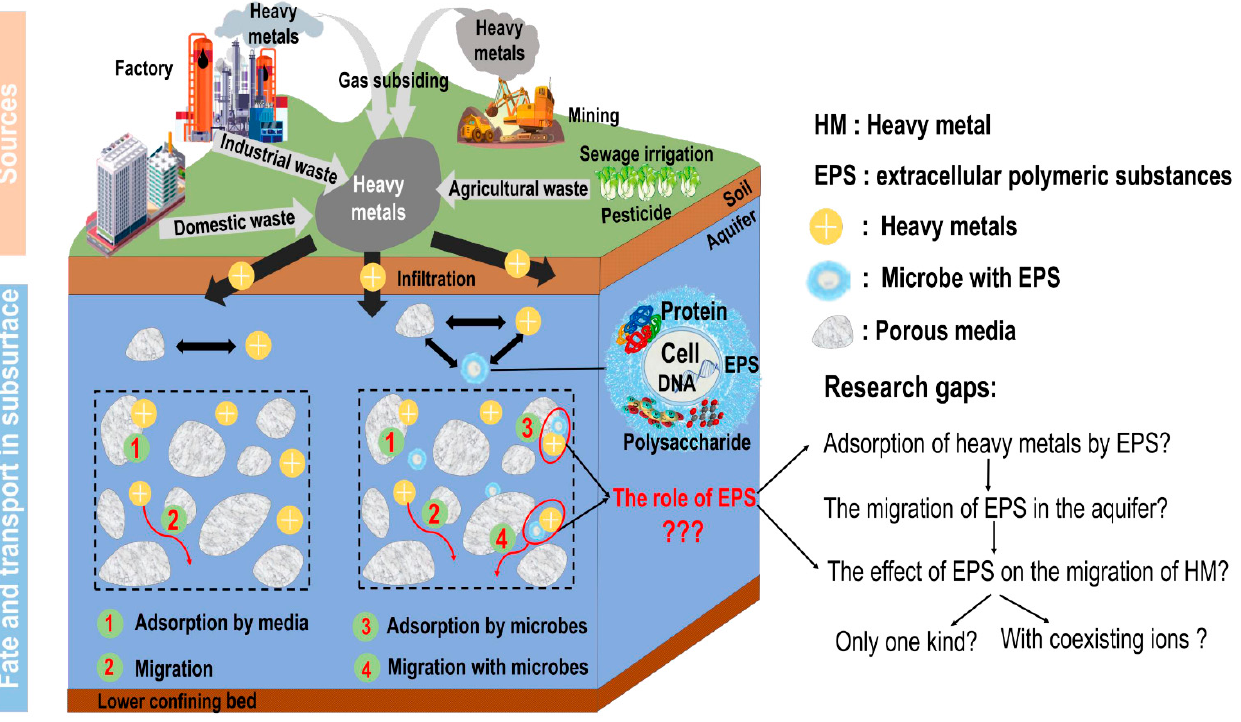
Figure 1. Heavy metals in the subsurface environment: sources, migration, and their interactions with extracellular polymeric substances (EPS).